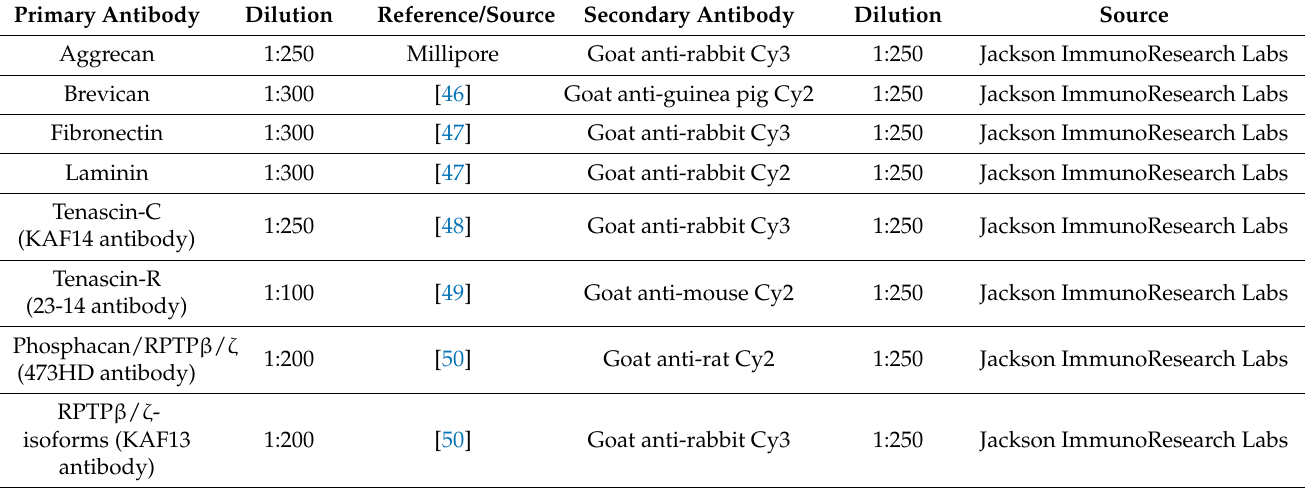
Table 2. Primary and secondary antibodies for immunohistochemistry.